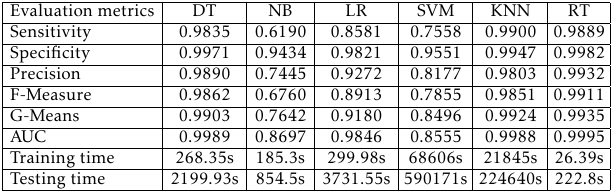
Table 6. Results of using Decorate when classifying DoS on UNSW-NB15 dataset